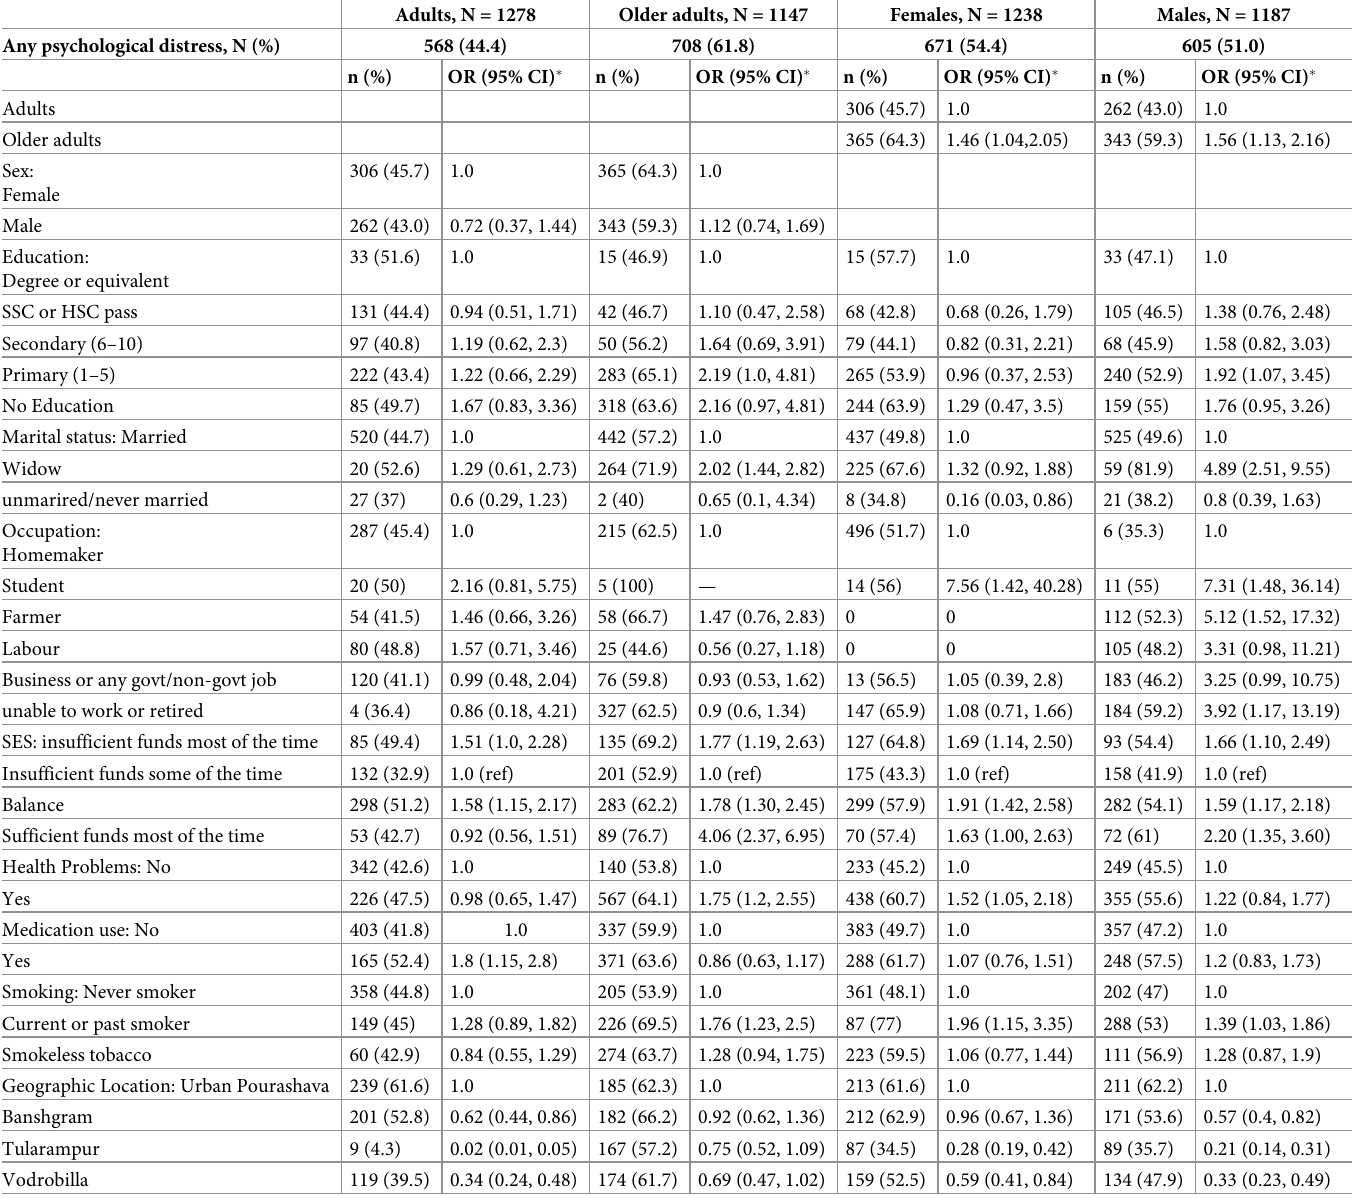
Table 3. Association of socio-demographic factors with any psychological distress for adults and older adults, and for males and females. Adults, N =